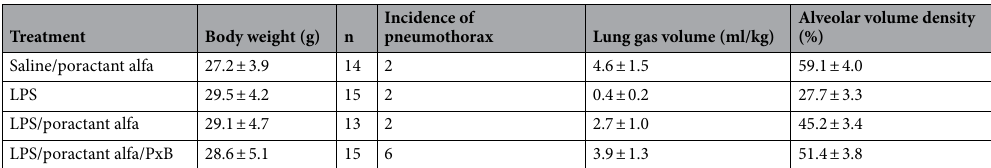
Table 1. Body weight, numbers, incidence of pneumothorax, lung gas volume and alveolar volume density in preterm newborn rabbits exposed to saline or LPS, and treated with exogenous surfactant with or without PxB. Values of body weight, lung gas volume and alveolar volume density are mean ± SD; n , number of animals included in final statistical analysis. Positive controls received saline at birth and were treated with poractant alfa. LPS exposed and non-treated animals were used as negative controls. Statistical analysis by one-way ANOVA for lung gas volume: LPS vs. saline/poractant alfa and LPS/poractant alfa/PxB, P < 0.001 and LPS vs. LPS/poractant alfa, P < 0.01; LPS/poractant alfa vs. saline/poractant alfa P < 0.01; alveolar volume density for all between-group differences, P < 0.001.